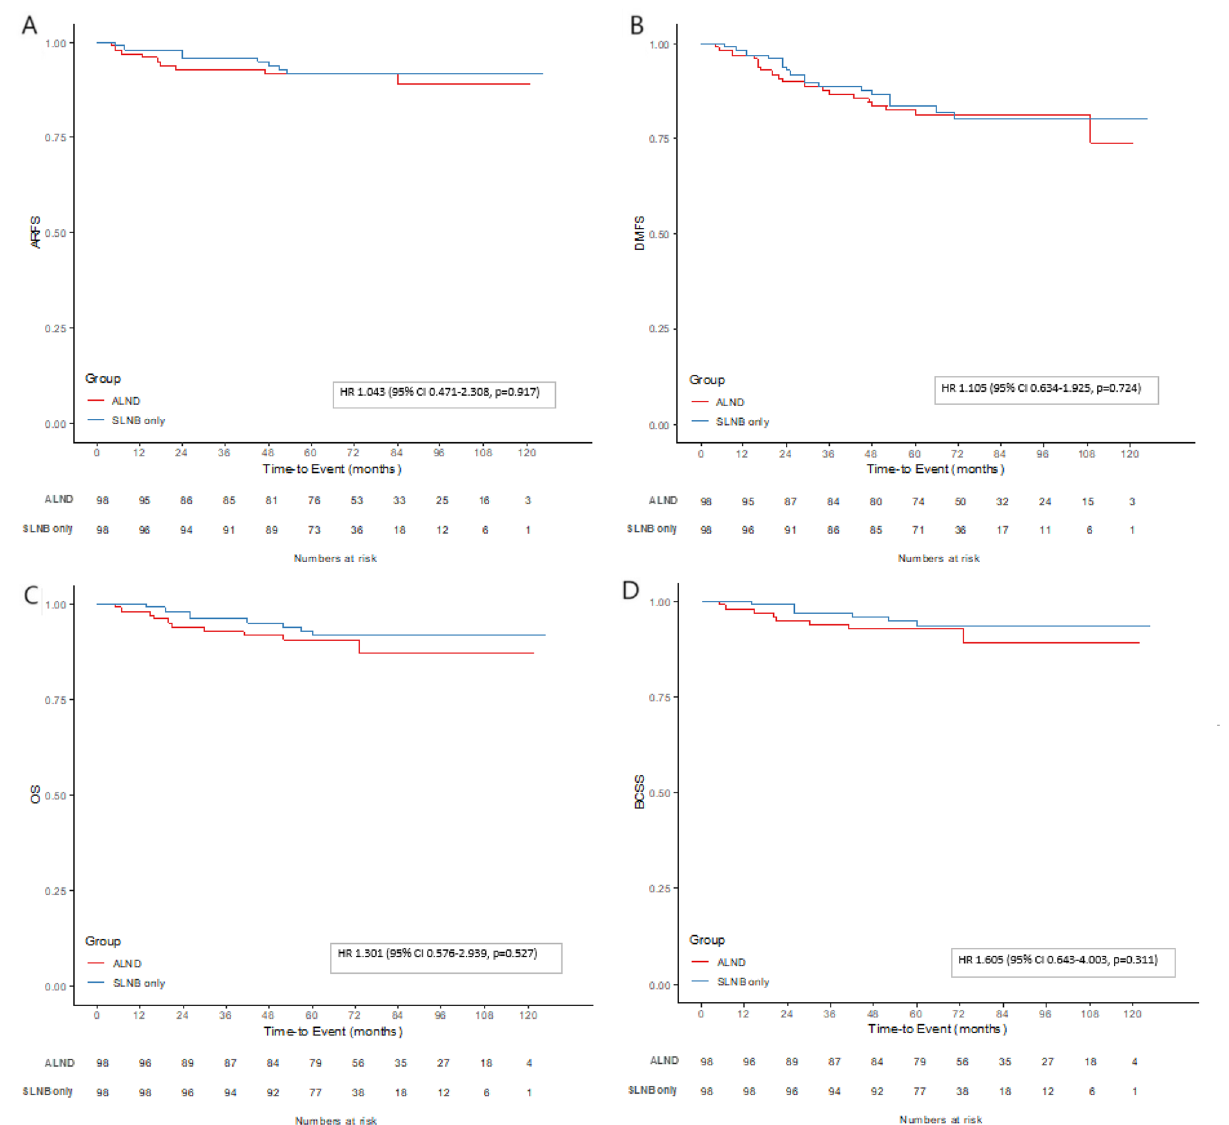
Figure 2. Propensity score-matched Kaplan–Meier survival analysis of ( A ) axillary recurrence-free survival (ARFS), ( B ) distant metastasis-free survival (DMFS), ( C ) overall survival (OS), and ( D ) breast cancer-specific survival (BCSS) between the sentinel lymph node biopsy (SLNB) only and axillary lymph node dissection (ALND)